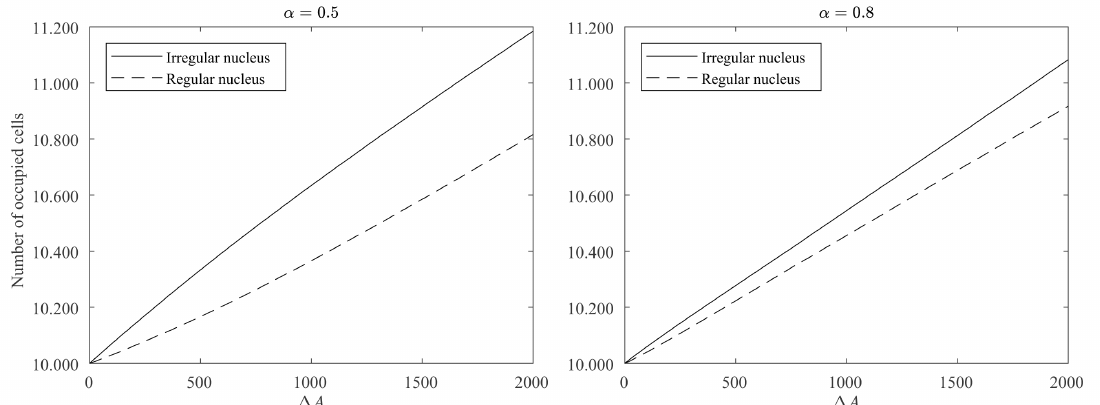
Figure 11. Evolution of the number of occupied cells for irregular and regular nuclei. We computed the mean of 100 simulations with the same parameter values as those used in the simulation of Figure 10 with α = 0.5 and α =